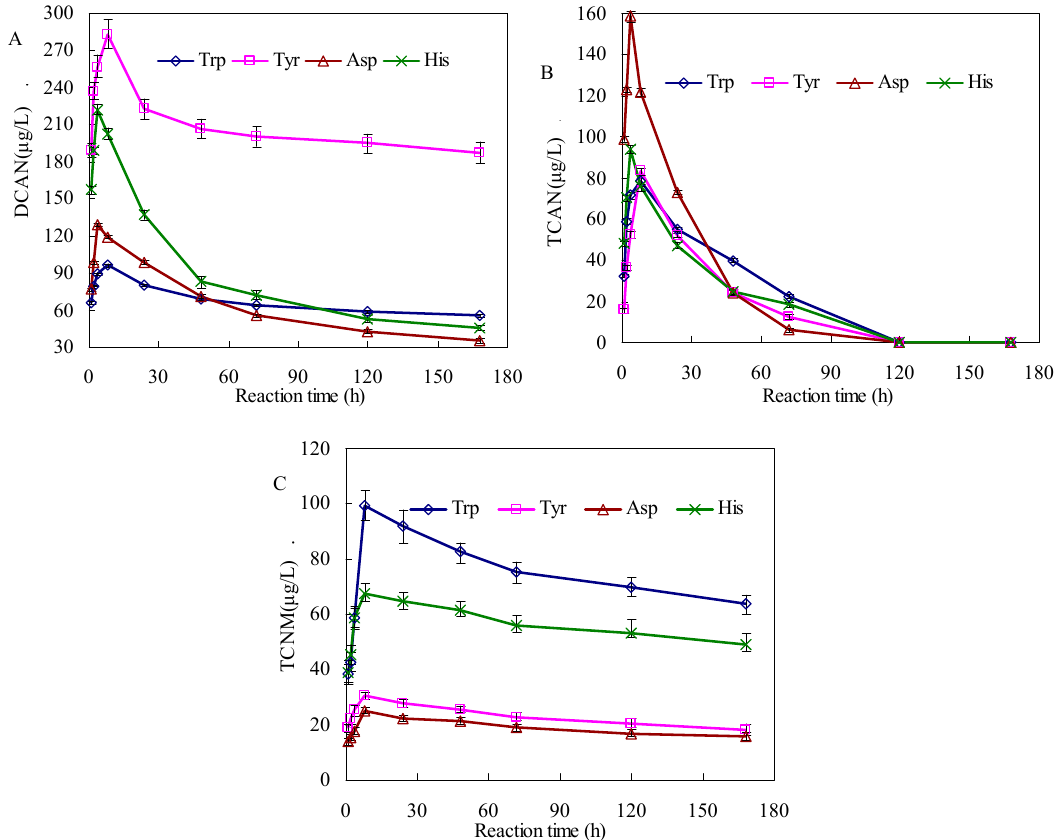
Figure 1. Formation of haloacetonitriles (HANs) ( A , B ) and trichloronitromethane (TCNM) ( C ) during chlorination of tryptophan (Trp), tyrosine (Tyr), aspartic acid (Asp), and histidine (His) at different contact times (Trp = 0.1 mM, Tyr = 0.1 mM, Asp = 0.1 mM, His = 0.1 mM, temperature = 22 ± 1 °C, pH = 7 ± 0.2, and Cl 2 = 3 mM). The bars represent the standard deviation of replicate measurements ( n = 3).